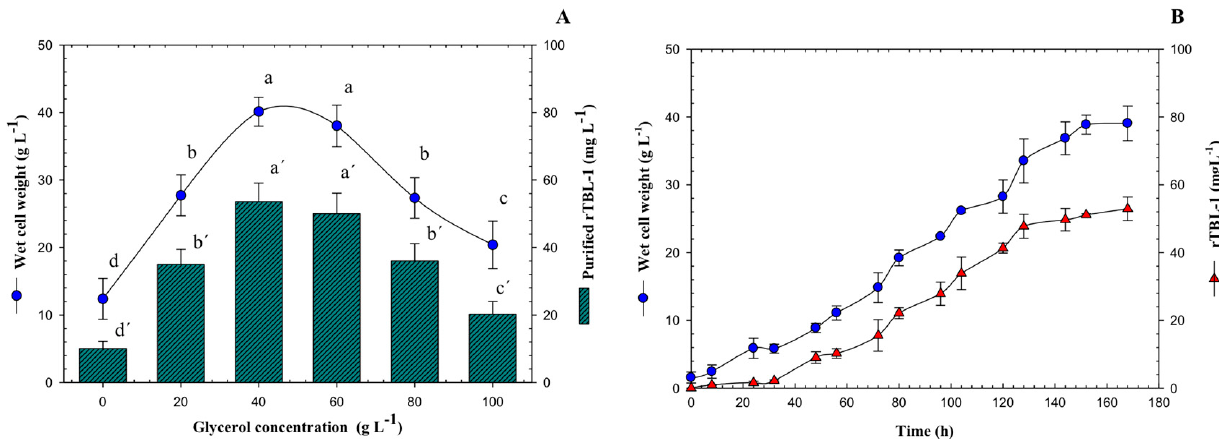
Figure 1. ( A ) Kinetic profile of wet cell weight and rTBL-1 production using 40 g L − 1 of G99 in batch culture. ( B ) Effect of substrate concentration on rTBL-1 and wet cell weight production of P. pastoris in batch culture using G99 after 168 h of growth at the following operating conditions: 30 ◦ C and 200 rpm, Erlenmeyer flask level. Error bars correspond to the standard deviation of three independent determinations. Different letters represent significant differences ( p ≤ 0.05; Tukey, SAS System Version 9, NC, USA) between treatments for wet cell weight or for rTBL 1.